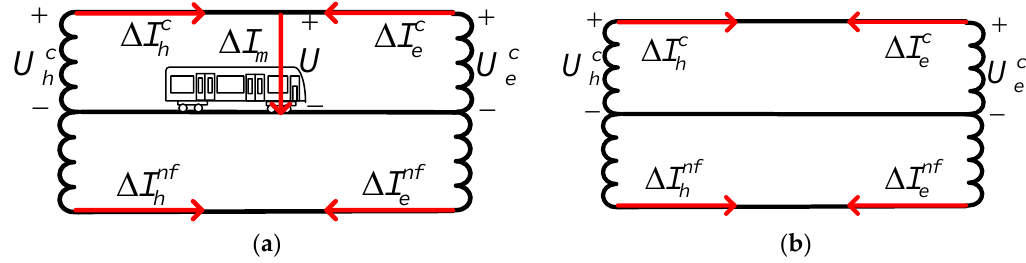
Figure 6. Maximum increment current distribution at the AT subsections: ( a ) At the EMU running subsection and ( b ) at the no EMU running subsection.